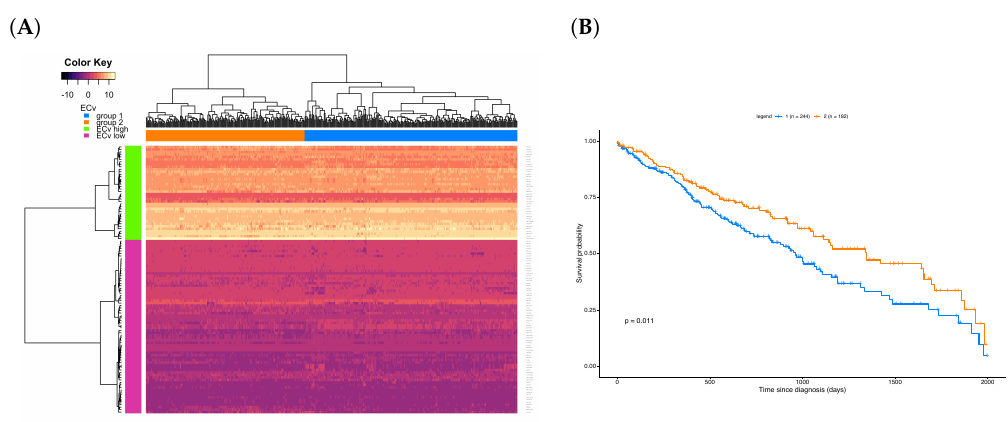
Figure 6. Unsupervised clustering and survival analysis for Lung Squamous Cell Carcinoma (LUSC). ( A ) Heat map with hierarchical clustering for the ECv matrix of 108 edges with 426 samples in LUSC RNA-Seq data. ( B ) Kaplan-Meier curves for the two patient groups; group 1 (blue, n: 244) and group 2 (orange, n: 182), corresponding the patient clusters in the heat map in A. The survival analysis was performed using log-rank test for p value